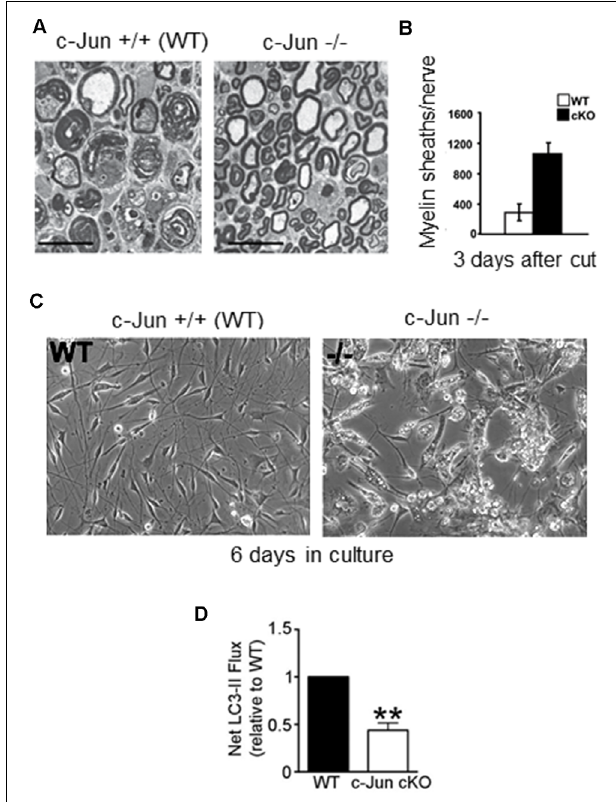
FIGURE 6 | Myelin clearance and autophagy are regulated by c-Jun. (A) Electron micrograph of 3-day cut WT and c-Jun cKO sciatic nerves, showing relative preservation of intact myelin sheaths in the mutant; quantification shown in (B) . (C) Failure of myelin breakdown in c-Jun cKO Schwann cells in culture, shown by the persistence of myelin debris in mutant cells maintained for 6 days in vitro . (D) c-Jun cKO nerves show reduced autophagic flux (LC3 ll accumulation) compared to WT nerves (modified from Gomez-Sanchez et al.,